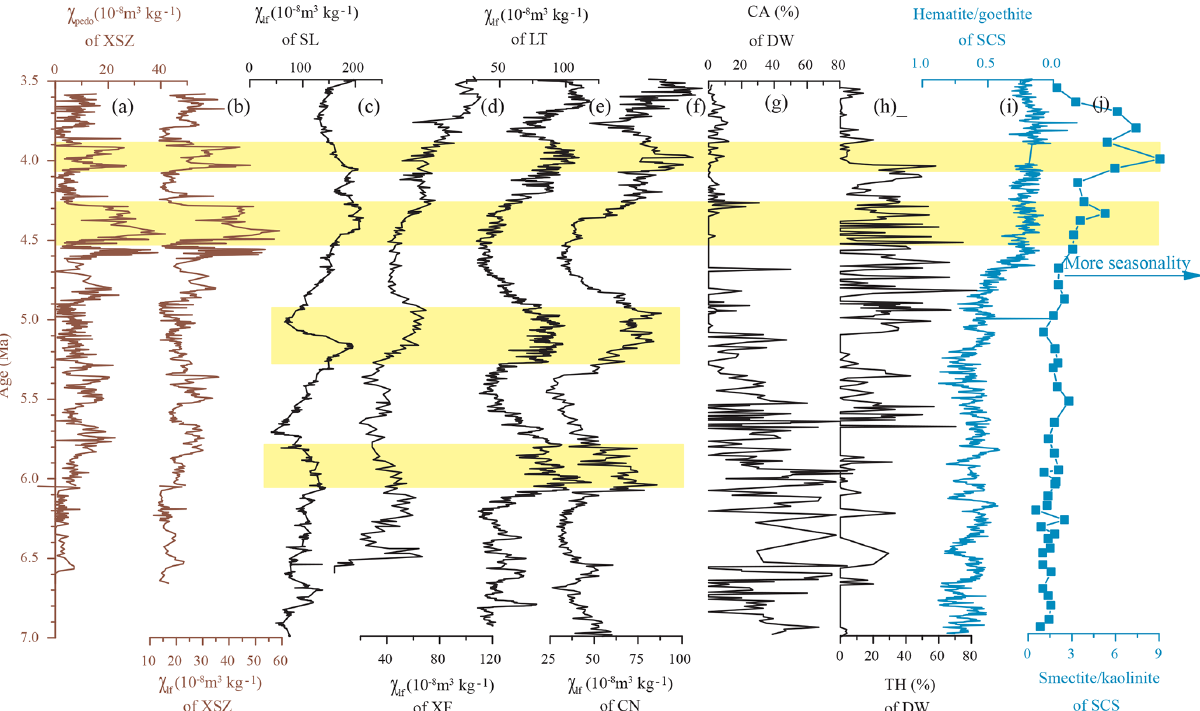
Figure 7. Comparison of late Miocene–Pliocene paleoclimatic records from Asia. (a–b) χ pedo and χ lf from the XSZ section. (c–f) χ lf record from Shilou (Ao et al., 2016), Xifeng (Guo et al., 2001), Lingtai (Sun et al., 2010), and Chaona (Song et al., 2007). (g–h) Percentages of cold-aridiphilous (CA) mollusks and thermo-humidiphilous (TH) mollusks from Dongwan (Li et al., 2008). (i) Hematite / goethite ratio from sediments of the South China Sea (Clift, 2006), and (j) smectite / kaolinite ratio from the South China Sea (Wan et al., 2010; Clift et al.,